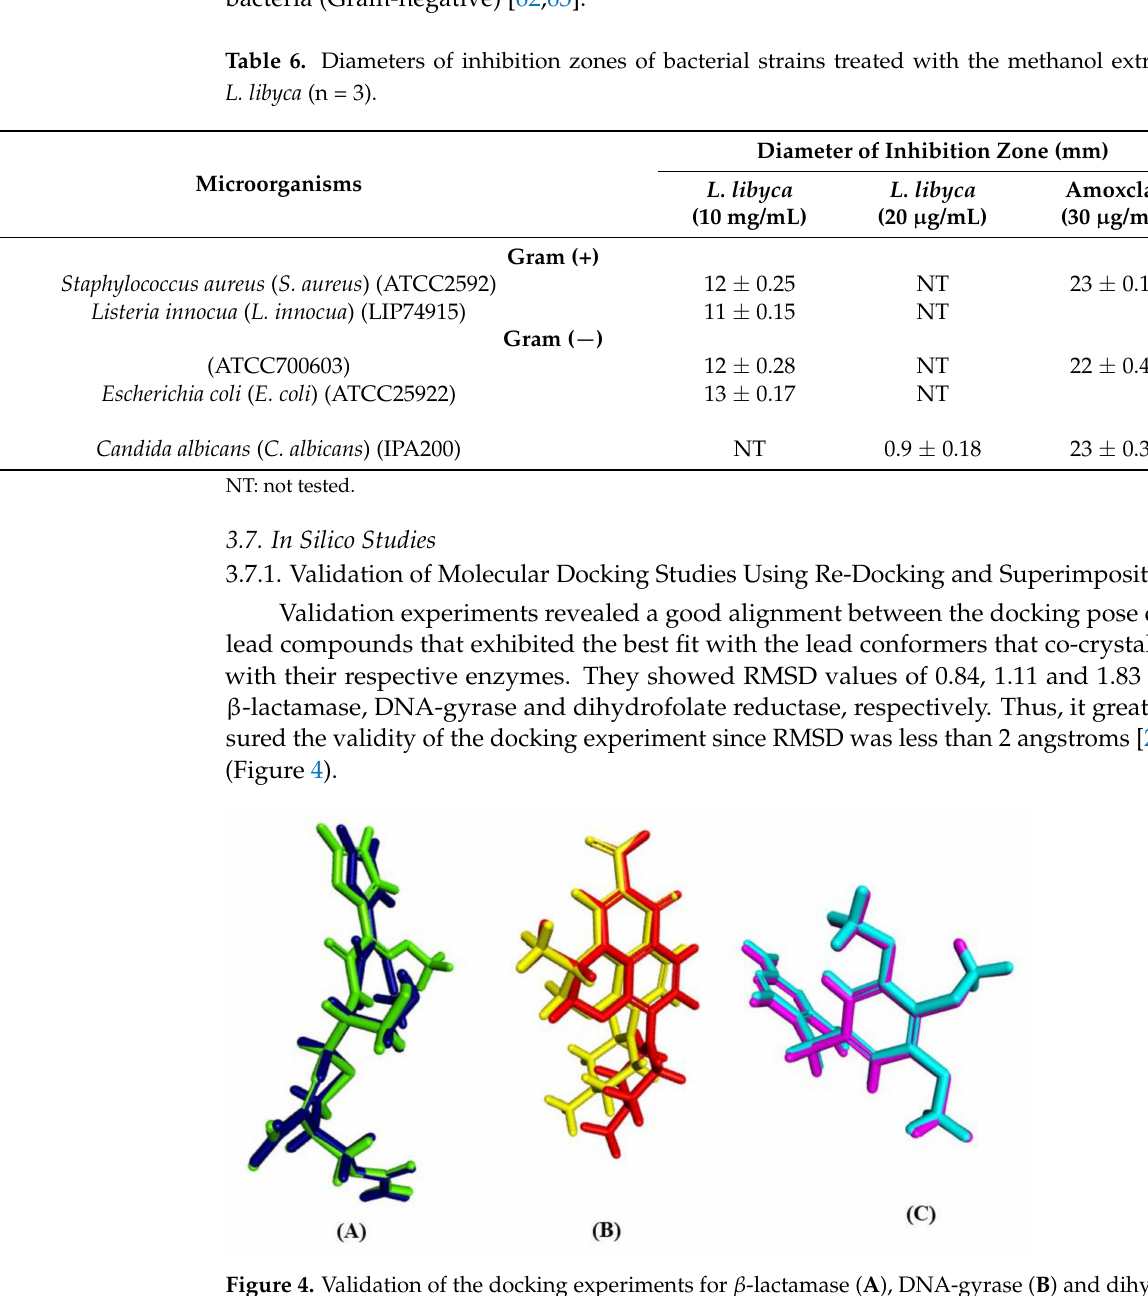
Figure 4. Validation of the docking experiments for β -lactamase ( A ), DNA-gyrase ( B ) and dihydrofo- late reductase ( C ) using re-docking and